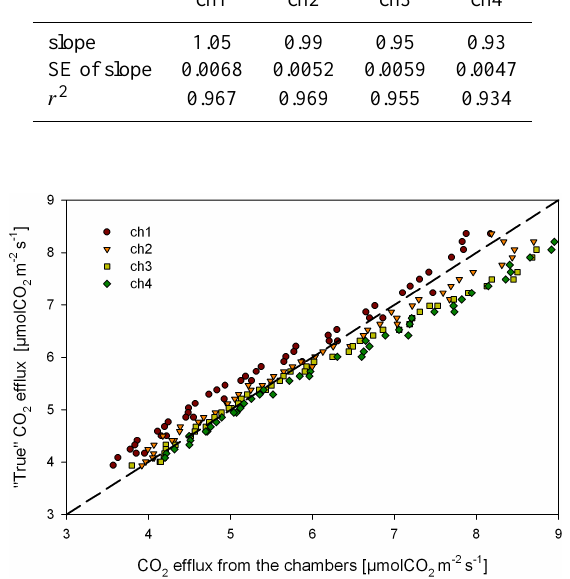
Fig. 3. CO 2 fluxes from the calibration tank (“true” CO 2 efflux) vs. the fluxes as measured by the four chambers (ch1–4) of the soil respiration system. The 1:1 line is shown (dashed line).